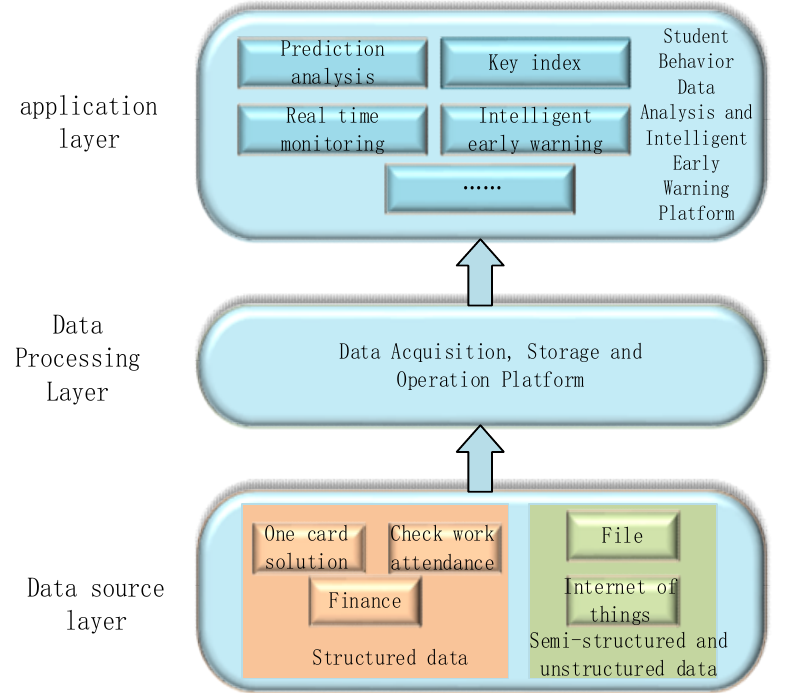
Figure 2. Technical Architecture of